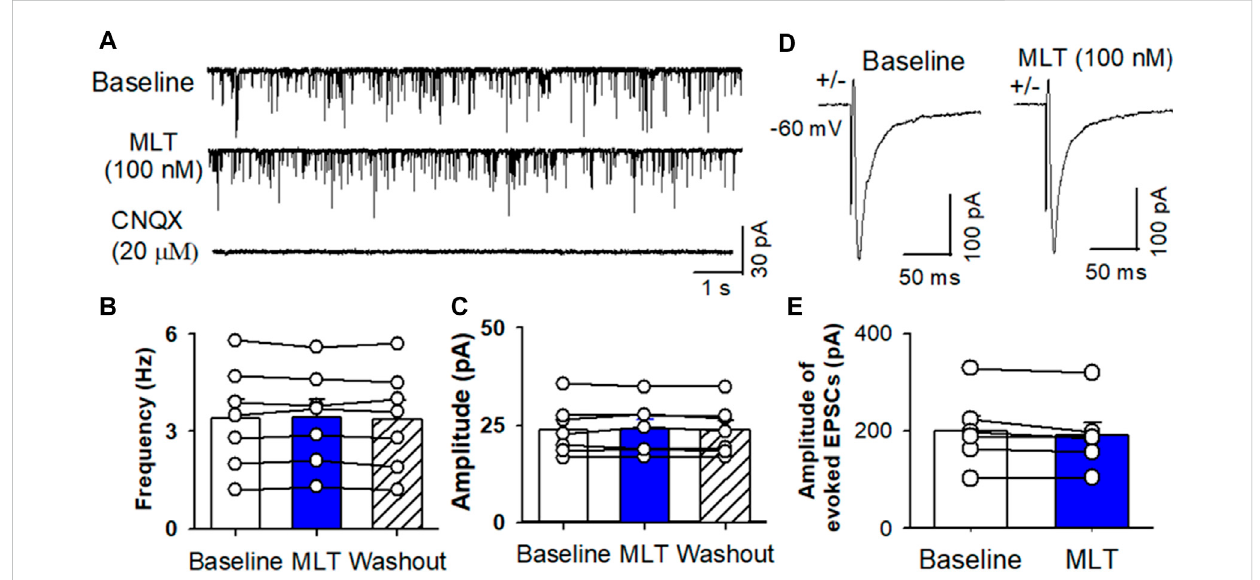
Effect of melatonin on glutamatergic mEPSCs and evoked EPSCs in RVLM projecting PVN neurons. (A) Representative raw tracings from a labeled RVLM projecting PVN neuron show that mEPSCs recorded during control, application of 100 nM melatonin, and application of 20 μ M CNQX. (B,C) , Summary data show the effect of 100 nM melatonin on the frequency (B) and amplitude (C) of mEPSCs of 6 labeled PVN neurons. (D,E) , Representative raw tracings (D) and summary data of amplitude of evoked EPSCs (E) show that 100 nM melatonin did not change the amplitude of evoked EPSCs. Data are presented as means ± SEM (* p < 0.05 compared with the control; ANOVA, followed by Dunn ’ s post hoc test). MLT,